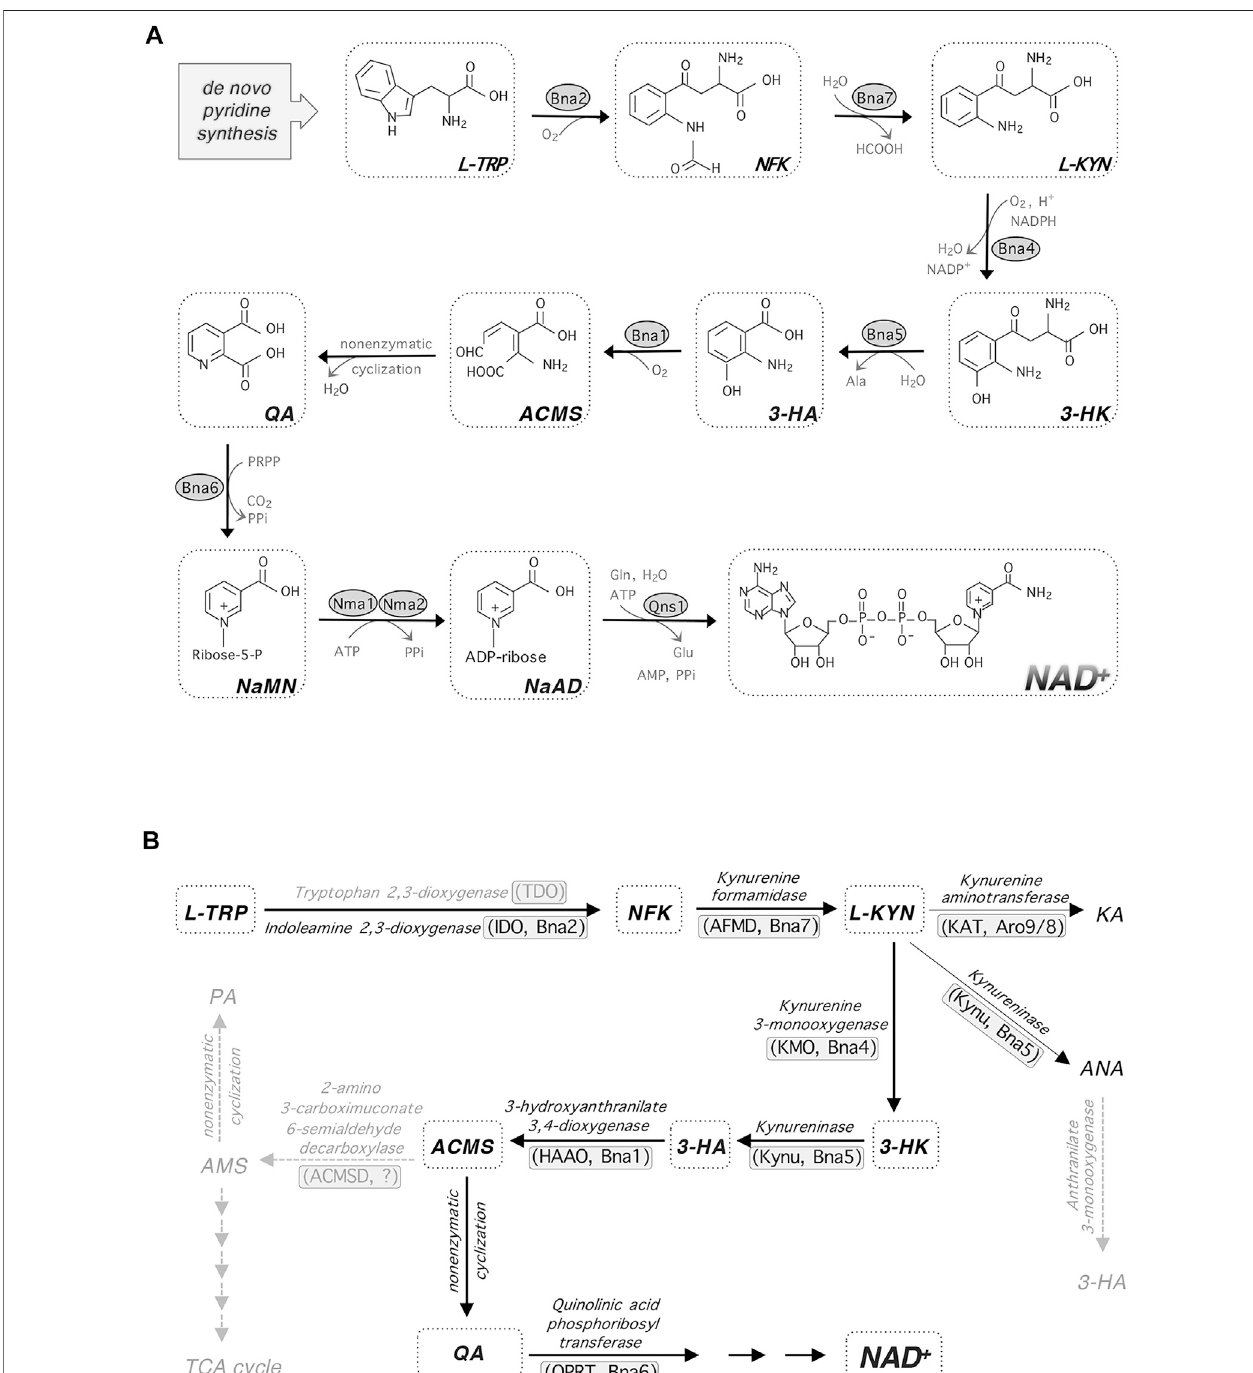
FIGURE2| denovo NAD + synthesisandkynureninemetabolism. (A) denovo NAD + synthesisstartswithL-TRPinbuddingyeastandmosteukaryotes.Enzymatic reactions of Bna2, Bna4 and Bna1 requires molecular oxygen. (B) In addition to feeding into NAD + synthesis, L-KYN is also converted to KA and ANA. The enzymes mediating each step are shown along with their abbreviations in parentheses ( left, in mammals; right, in yeast ). Steps shown in gray indicate that they may be missing in yeast. Abbreviations of metabolites and enzymes: HCOOH, formic acid. Ala, alanine. PRPP, phosphoribosyl pyrophosphate. PPi, pyrophosphate. Gln, glutamine. Glu, glutamic acid. ACMS, 2-amino-3-carboximuconate-6-semialdehyde. KA, kynurenic acid. ANA, anthranilic acid. PA, picolinic acid. AMS, aminomuconic semialdehyde. ACMSD, ACM decarboxylase.